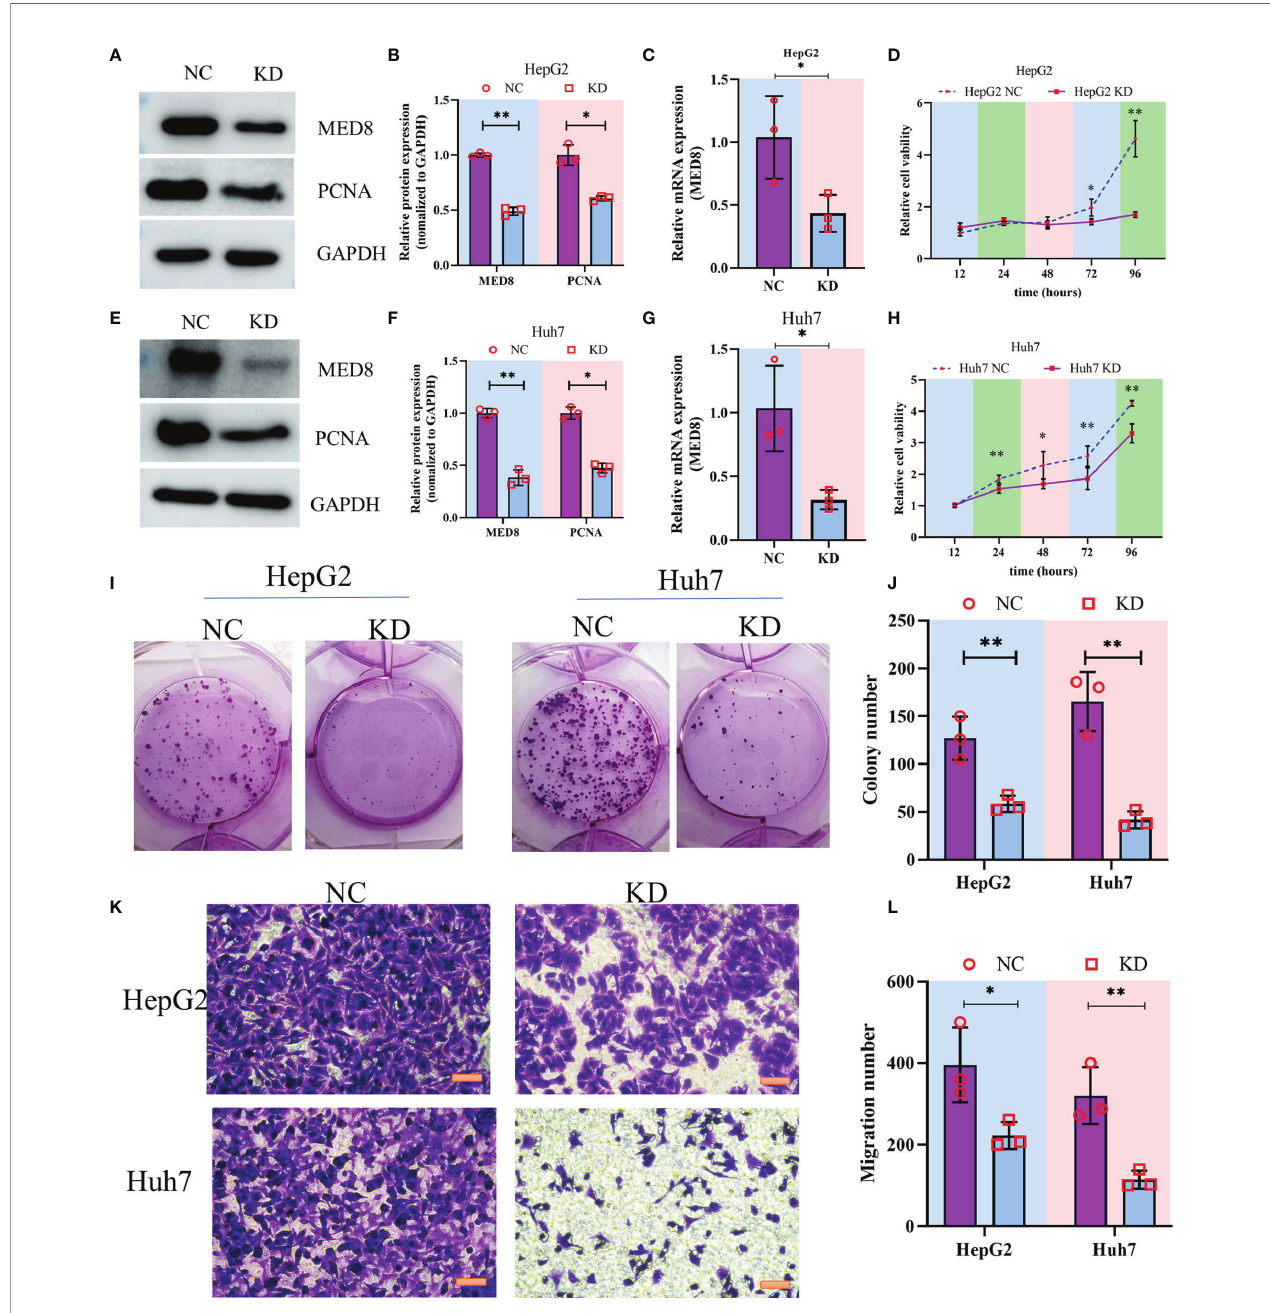
FIGURE 2 | The impact of MED8 knockdown in HCC cell lines. (A, E) Western blot analysis of the MED8 and PCNA expression levels in HepG2 (A) and Huh7 cells (E) after MED8 knockdown. (B, F) Relative quantitative analysis of MED8 protein expression level in HepG2 (B) and Huh7 cells (F) after MED8 knockdown. (C, G) qRT-PCR analysis of the MED8 expression level in HepG2 (C) and Huh7 cells (G) after MED8 knockdown. (D, H) The proliferation ratio of HepG2 (D) and Huh7 cells (H) from CCK-8 assays. (I, J) Colony-forming assays of HepG2 and Huh7 cells. (K, L) Migration assays of HepG2 and Huh7 cells. Scar bar: 50 m m. *: P < 0.05; **: P <